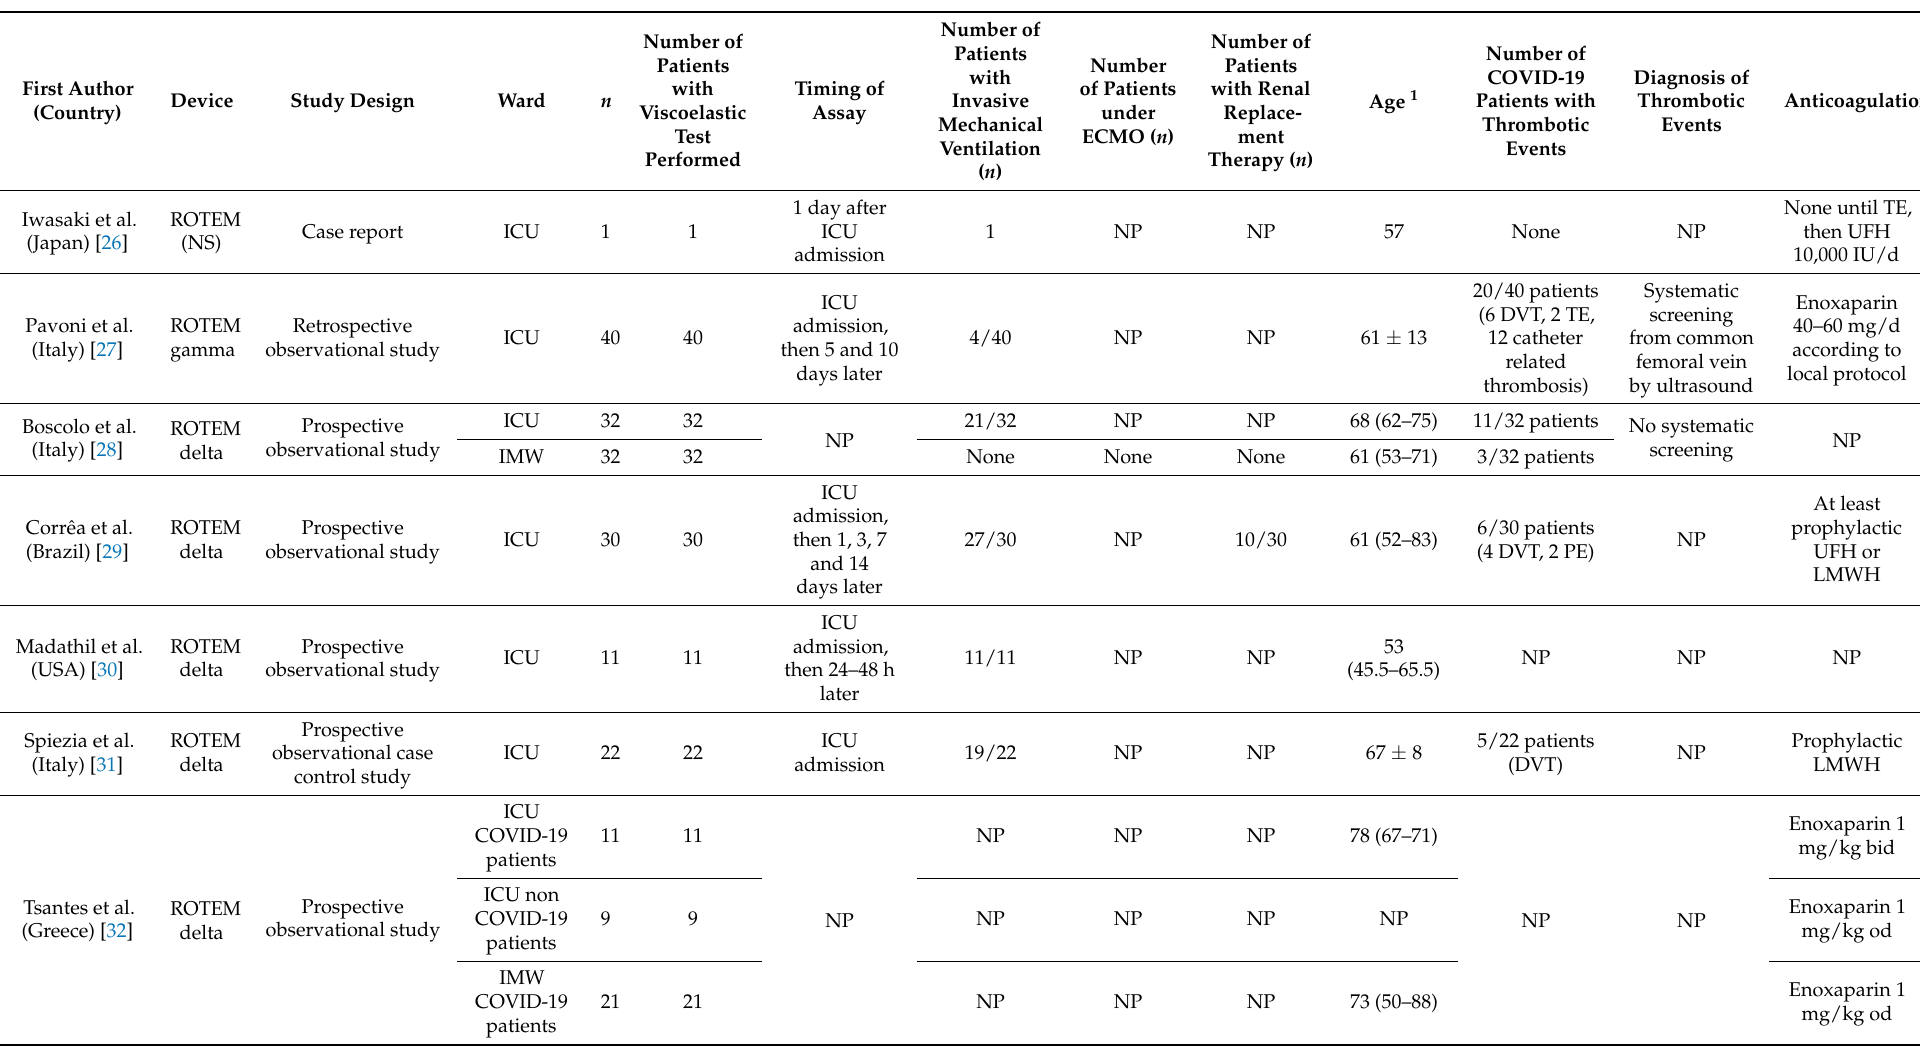
Table 3. Characteristics of the included